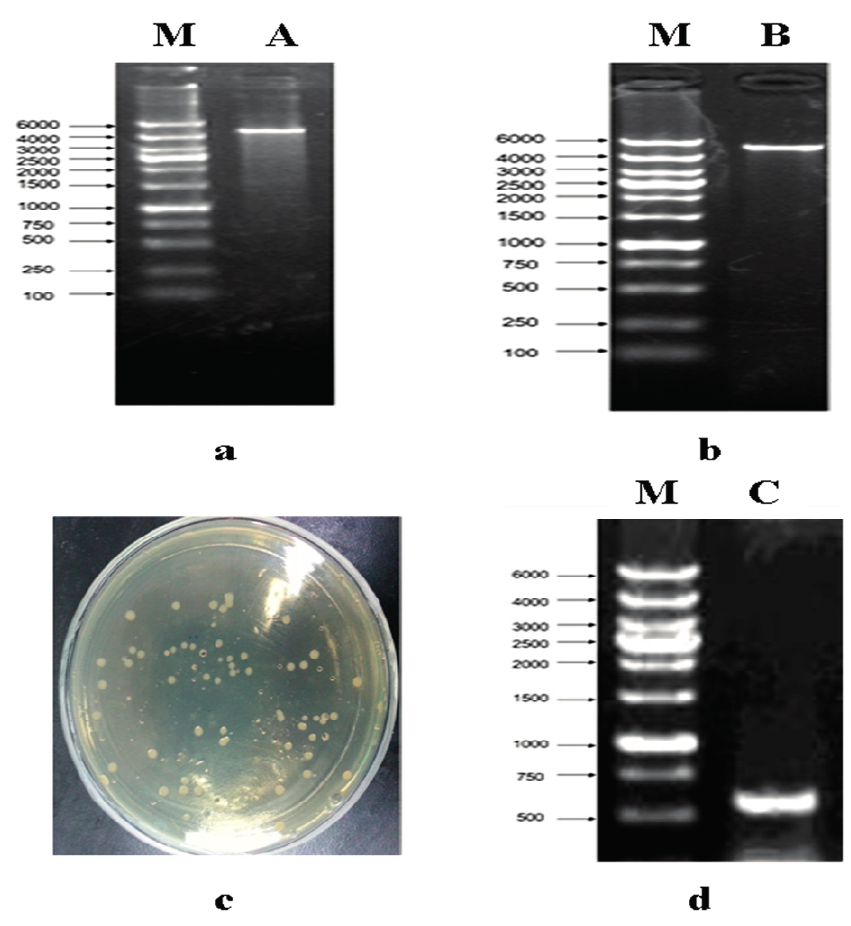
Figure 1. Construction of expressed vector pET32a (+) S. ( a ) line A, MscI digested of vector pET32a (+), the 5900 bp bands were present. Line M, DL6000 Marker; ( b ) line B, PCR products of linear vector pET32a (+), the 5900 bp band was present. Line M, DL6000 Marker; ( c ) the result of colone; ( d ) PCR products of pET32a (+) S, the 604 bp band was present. Line M, DL6000